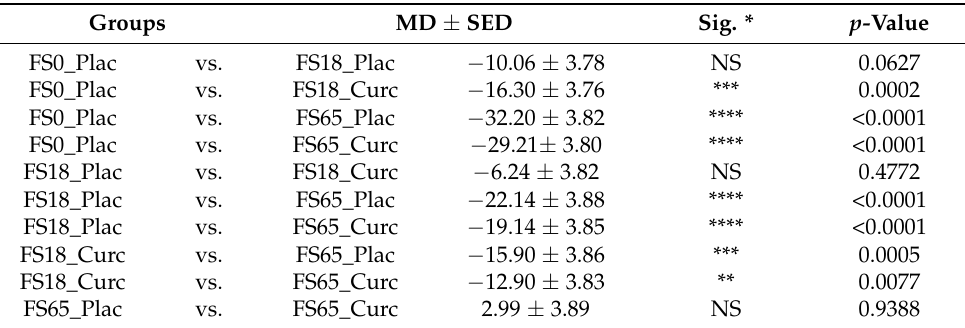
Table 4. Inter-group differences in transferrin saturation (TS %) at 180 min. Groups